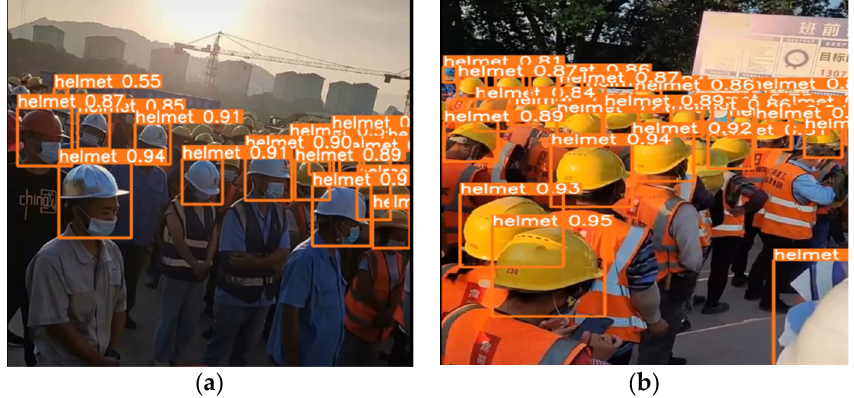
Figure 7. YOLOv5s video detection results. ( a ) missing detection; ( b ) full detection.